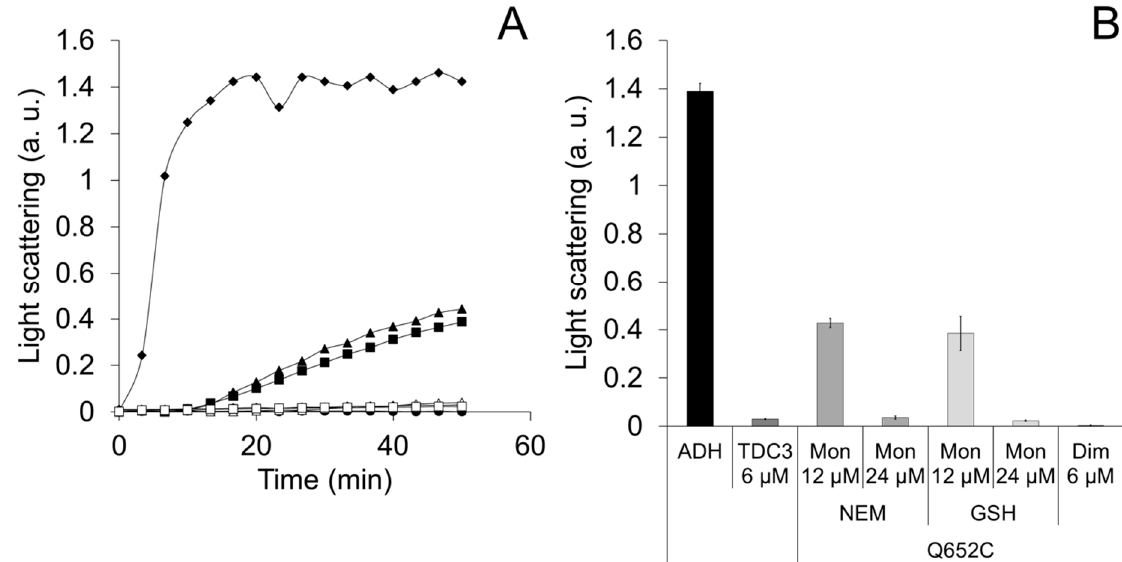
Figure 1. Unfolding activity of a TDC3 Q652C dimer and its derivatized monomer with either NEM or GSH. ( A ) Light-sca tt ering representative traces of ADH denaturing by incubation at 45 °C in the presence of TDC3 variants. ADH with BSA (6 µM) (control) (closed rhomboids), TDC3 (6 µM) (open squares), TDC3 Q652C disul fi de dimer (6 µM) (closed squares), NEM-derivatized TDC3 Q652C monomer (12 µM) (close triangles), NEM-derivatized TDC3 Q652C monomer (24 µM) (open triangles), glutathi- one-derivatized TDC3 Q652C monomer (12 µM) (closed circles), and glutathione-derivatized TDC3 Q652C monomer (24 µM) (open circles). ( B ) Average of three independent assays determined after 50 min.